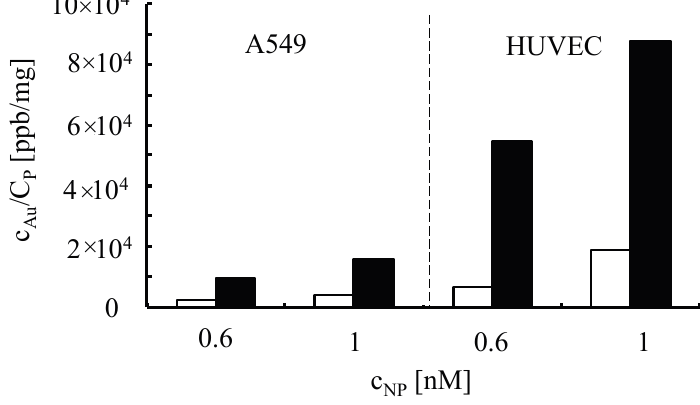
Figure 11. Internalization of Au-PEG NPs by A549 cells and HUVECs. A549 cells and HUVECs were incubated with Au-PEG NPs of c NP = 0.6 nM and c NP = 1 nM concentration cells in medium with (white bars) or without (black bars) serum. Twenty-four hours after adding the particles, the gold concentration c Au and the protein concentration C P was